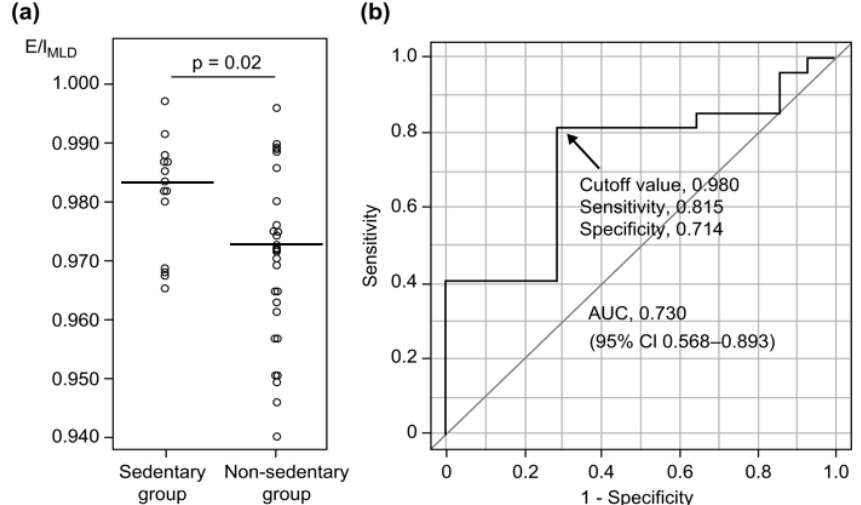
Figure 3. Comparison of E/I MLD for physical activity ( a ) and ROC curve evaluation of the utility of E/I MLD for detecting sedentary behavior in patients with COPD ( b ). A comparison of E/I MLD values between the sedentary (patients with EX values of < 1.5, n = 14) and nonsedentary (patients with EX values of ≥ 1.5, n = 27) groups demonstrates a statistically significant between-group difference (median, 0.983 vs. 0.972; p = 0.02). The ROC evaluation of the utility of E/I MLD for detecting sedentary behavior in patients with COPD is shown here. If the cutoff value of E/I MLD is 0.980 (arrow), the sensitivity and specificity are 0.815 and 0.714, respectively. The AUC is 0.730 (95% confidence interval, 0.568–0.893). Definition of abbreviations: E/I MLD , expiratory to inspiratory ratio of the mean lung density; ROC, receiver operating characteristic; COPD, chronic obstructive pulmonary disease; EX, exercise; AUC, area under the receiver operating characteristic curve. The horizontal bars indicate median values.